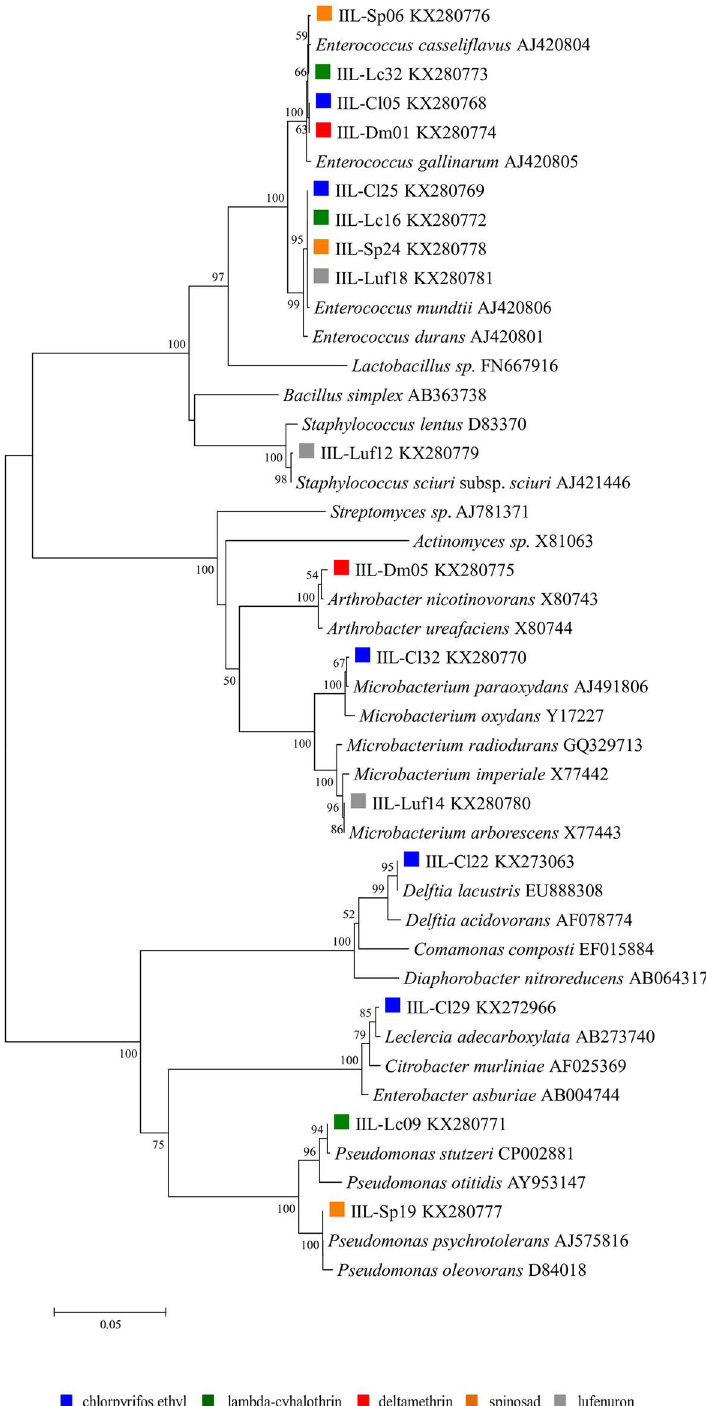
Fig 2. Neighbor-joining phylogenetic tree of bacterial isolates obtained from the larval gut microbiota of insecticide-resistant lines of Spodoptera frugiperda . Tree was built using 1350 bp sequencesof the 16S rDNA. Support bootstrapvalues are shown in the branches. Scale bar indicates0.02 substitutionsper nucleotide position.